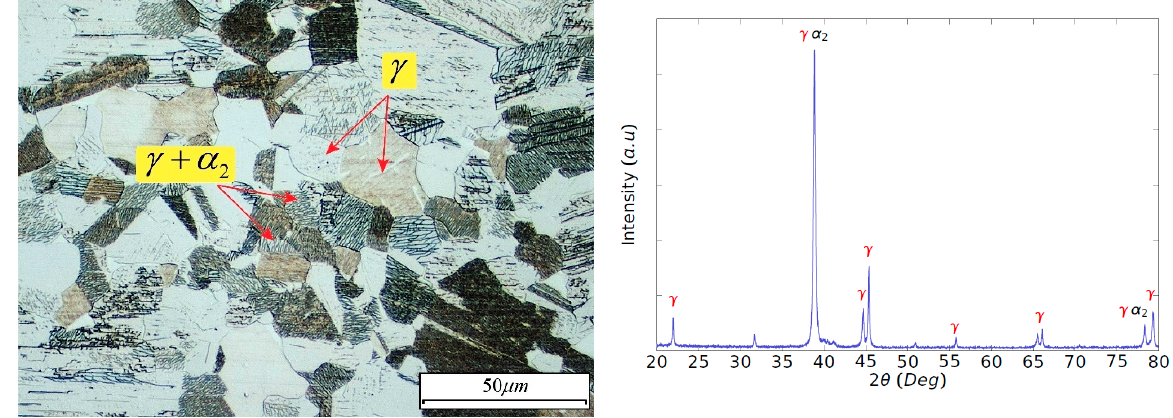
Figure 1. ( a ) Microstructure and ( b ) XRD pattern of the Ti48Al2Cr2Nb alloy.